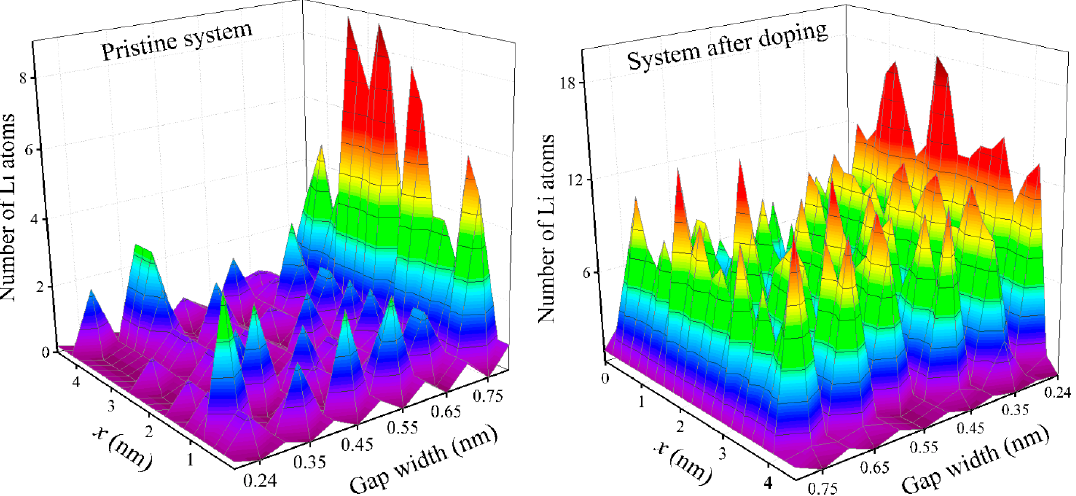
Figure 4. Density profiles of lithium in a silicene channel in a zigzag direction, obtained as a result of the intercalation of Li + ions into the channel (with walls of pristine silicene (left) and silicene processed by the NTD method (right)).